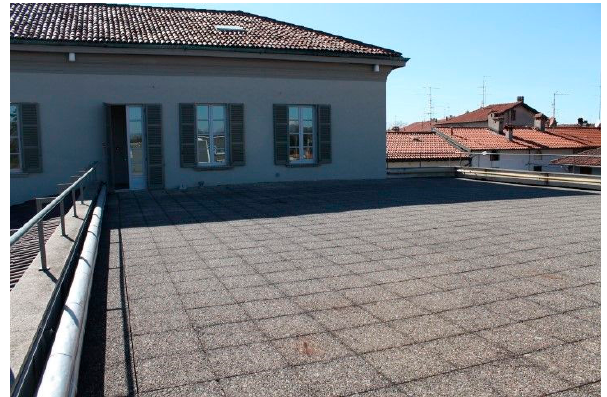
Figure 1. Imagine of the roof terrace of Fondazione Minoprio.